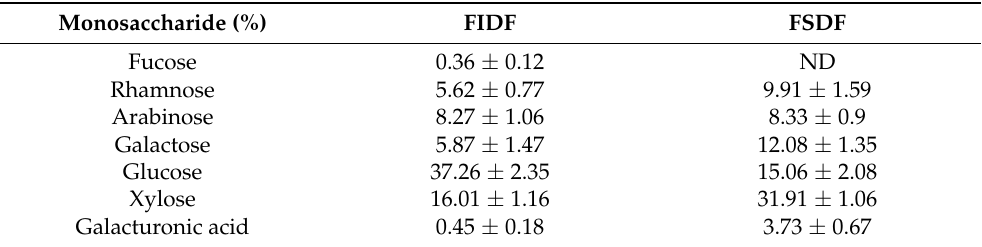
Table 1. The monosaccharide compositions (%) of FIDF and FSDF extracted from flaxseed cake. Data are expressed as mean ± SEM from three independent experiments.